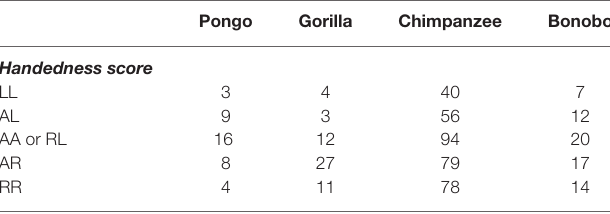
TABLE 2 | Distribution of consistency in hand preference between species. Pongo